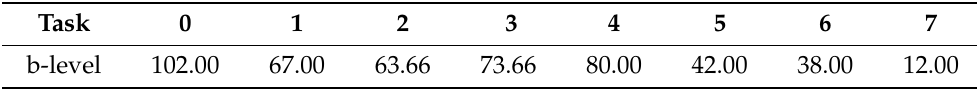
Table 9. b-level values for the DAG in Figure 1.